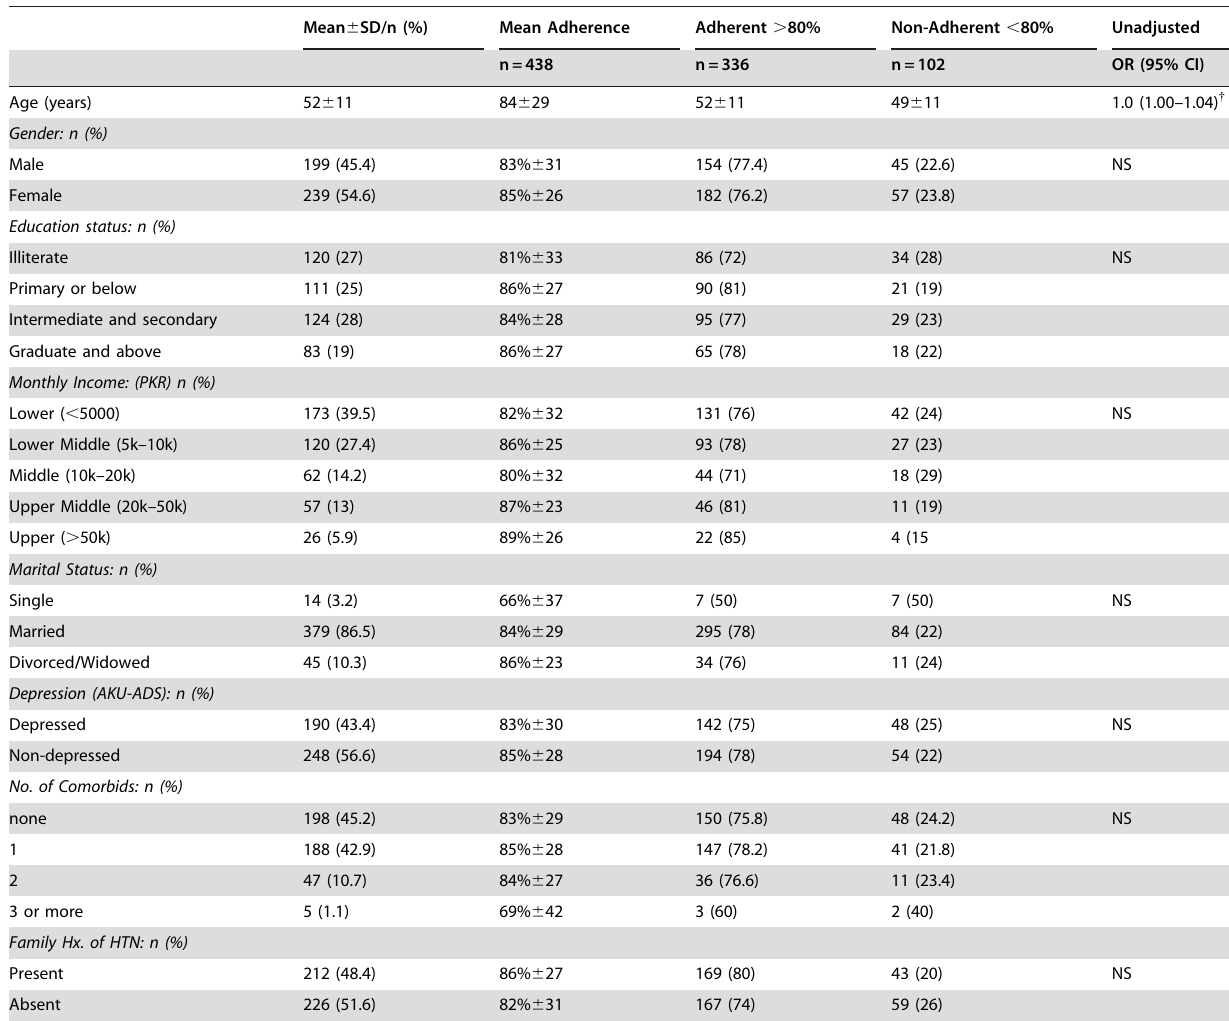
Table 1. Demographic and clinical characteristics of the study population .. ... .... ... ... .... ... ... .... ... ... .... ... ... .... ... ... .... ... ... .... ... ... .... ... ... .... ... ... .... ... ... .... ... ... .... ... ... .... ... ... .... ... ...